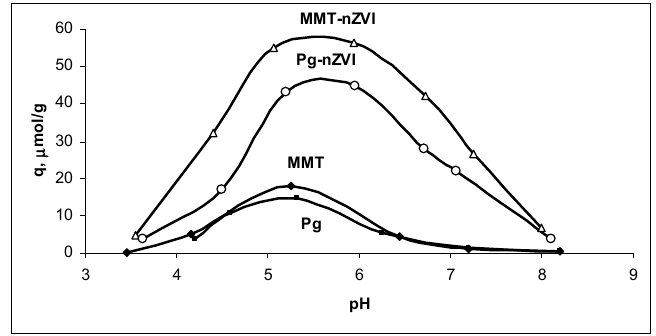
Figure 10. Sorption of U(VI) ions on pristine and nZVI-modified montmorillonite and palygorskite from mineralized waters as a function of pH.